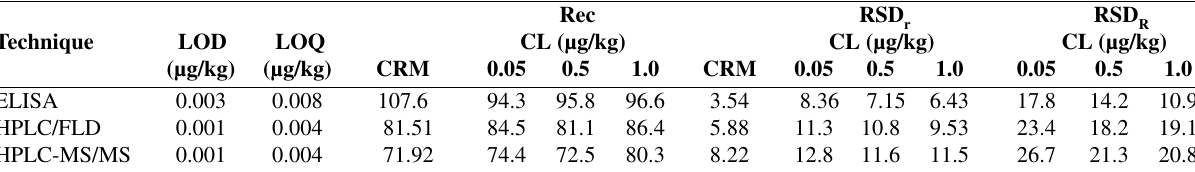
Table 1. Analytical parameters for the determination of AFM1 obtained with different